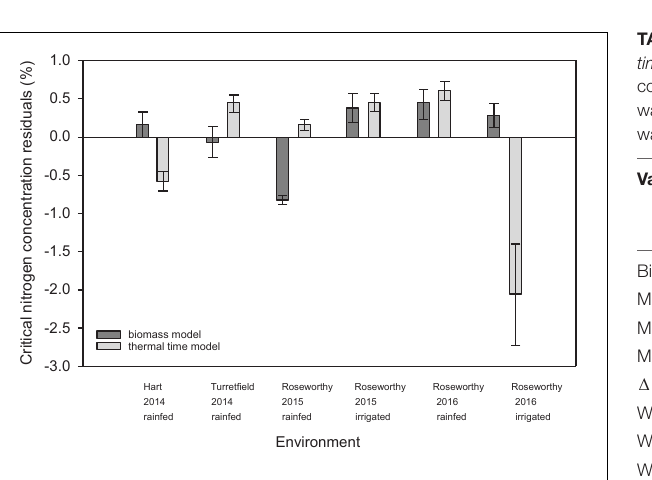
FIGURE 5 | Comparison of residuals for the biomass and thermal time models in five environments resulting from combination of locations, seasons and water regimes. Values are means ± standard error.